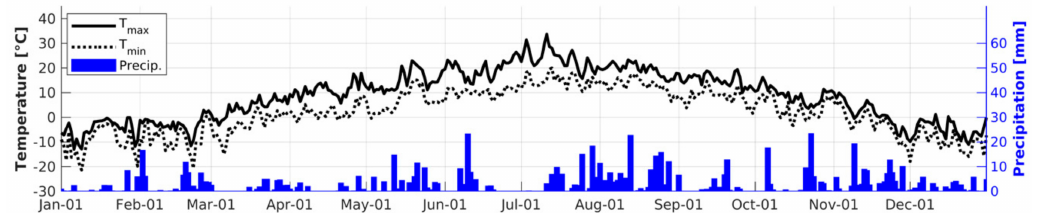
Figure 4. Daily minimum and maximum air temperature and precipitation in 2010 measured at a weather station located close to the test site in Remningstorp.